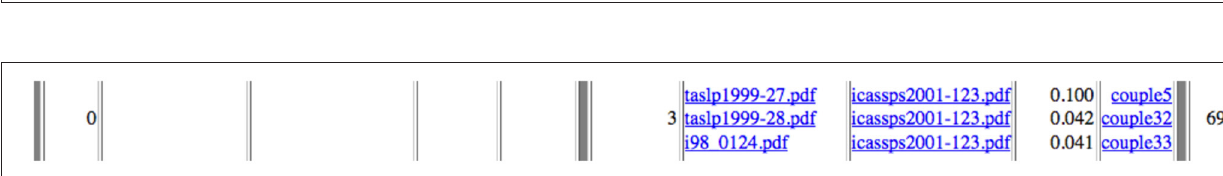
FIGURE 24 | Example of ICASSP 2001 Speech papers reusing ( left : no case identified) and plagiarizing ( right : 3 cases identified) other papers with similarity scores.